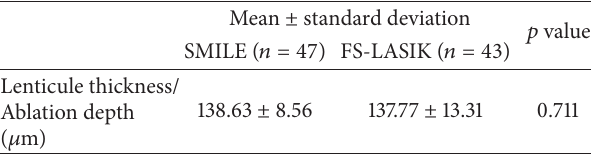
Table 2: Lenticule thickness/ablation depth.